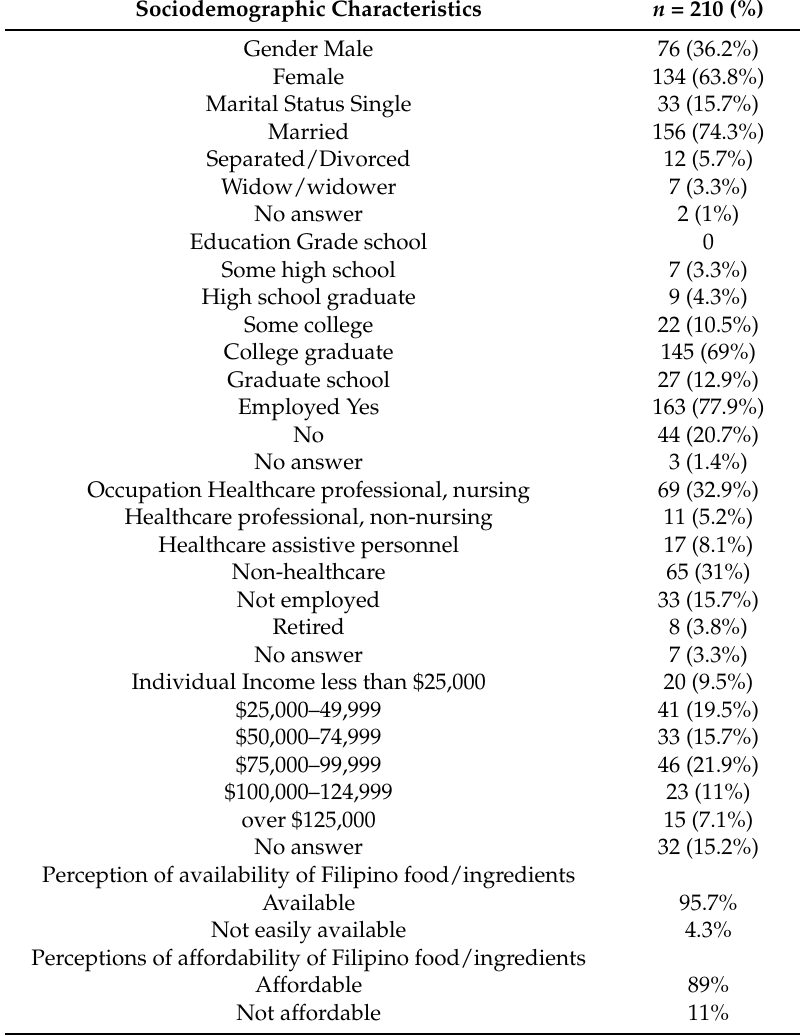
Table 1. Socio demographic variables.